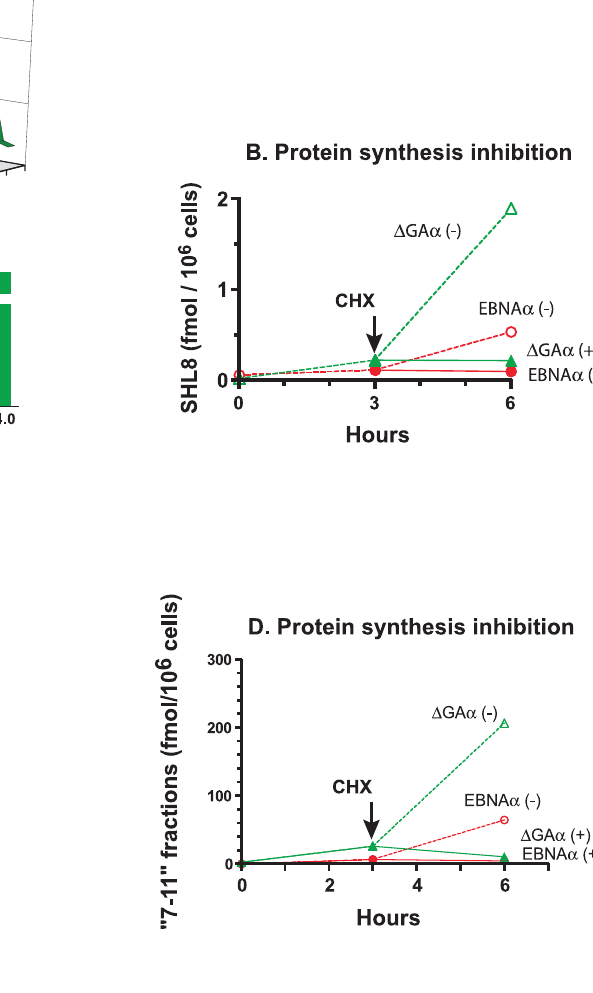
Figure 6. Newly synthesized precursors are processed rapidly to the final SHL8 peptide. ( A ) HEK293 cells expressing K b MHC together with EBNA a (red) or D GA a (green) were treated with doxycycline. At the indicated time points, peptides were extracted from the cells and fractionated by reverse phase HPLC. The fractions were assayed without any further treatment using B3Z T cells and K b -L cells as APC and quantitated using synthetic SHL8 as a standard (upper panel). The total SHL8 recovered at different time points is indicated in lower panel. Data are representative of 3 different experiments. ( B ) Protein expression was induced in the same cells with doxycycline for 3 h. The cells were treated ( + ) with the protein synthesis inhibitor cycloheximide or used as such ( 2 ). The total amount of SHL8 eluted in fractions 17 to 22 was measured at 0 h, 3 h and 6 h. Arrow indicates addition of cycloheximide. Data shown are typical of three different experiments. ( C ) HEK293 cells expressing EBNA a (red) or D GA a (green) were treated with doxycycline for the indicated times. The polypeptides were extracted and ‘‘SHL8’’ activity was quantitated as described in Fig. 4. Total ‘‘SHL8’’ activity in fractions ‘‘7–11’’ are presented in lower panel. Data is from three different experiments. ( D ) Same cells were stimulated 3 h with doxycycline following same treatments than in B. The ‘‘SHL8 activity’’ in fractions ‘‘7–11’’ was measured at 0 h, 3 h and 6 h, in the presence or not of cycloheximide. Arrow indicates addition of drug. Data shown are typical of three different experiments.